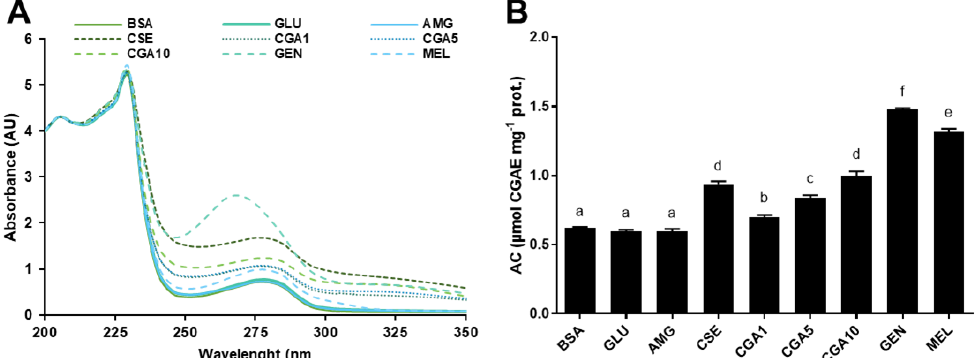
Figure 2. UV-Vis spectra ( A ) and antioxidant capacities ( B ) of the high molecular weight protein fractions ( > 30 kDa) isolated from the samples of the BSA-GLU glycation system (21 days incubation, 37 °C, pH 7.4) BSA: negative control; GLU: BSA + glucose; AMG: BSA + glucose + aminoguanidine; CSE: BSA + glucose + CSE (12,5 mg mL − 1 ); CGA1: BSA + glucose + 1 mmol L − 1 CGA; CGA5: BSA + glucose + 5 mmol L − 1 CGA; CGA10: BSA + glucose + 10 mmol L − 1 CGA; GEN: BSA + glucose + 5 mmol L − 1 genistein; MEL: BSA + glucose + 5 mmol L − 1 melatonin. Results are presented as mean ±